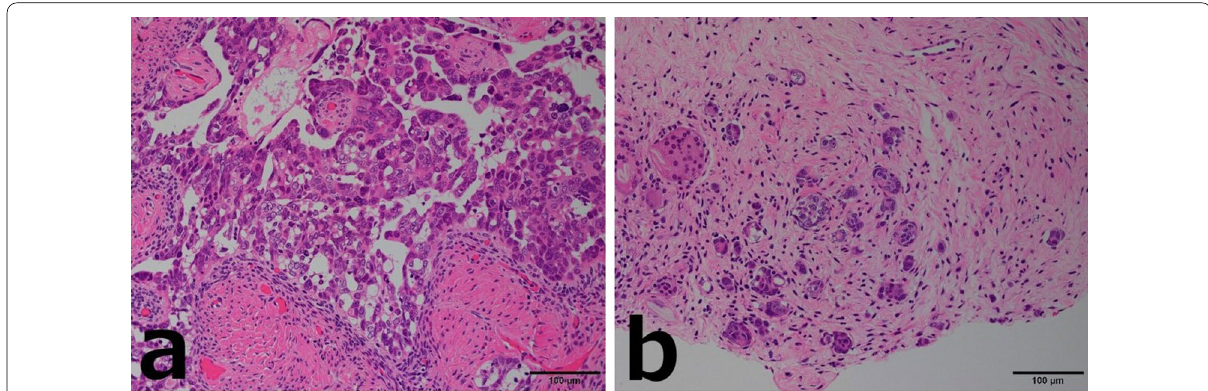
Fig. 4 Case 1: microscopic findings of the resected specimen (hematoxylin/eosin staining). a Ovarian histopathology. b Peritoneal histopathology. Both are similar to the histopathologic findings of breast tumors, with carcinoma cells arranged in irregular glands, micropapillary structures, and a small nested and slit-like pattern